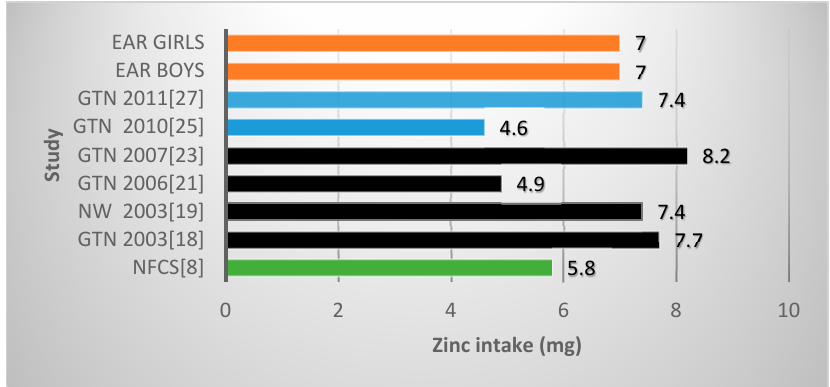
Figure 3. Mean zinc intake in studies on schoolchildren in South Africa between 2000 and 2015 with the blue bars representing two studies which included fortification values. EAR: estimated average intake; GTN: Gauteng; NW: North West; NFCS: National Food Consumption Survey.